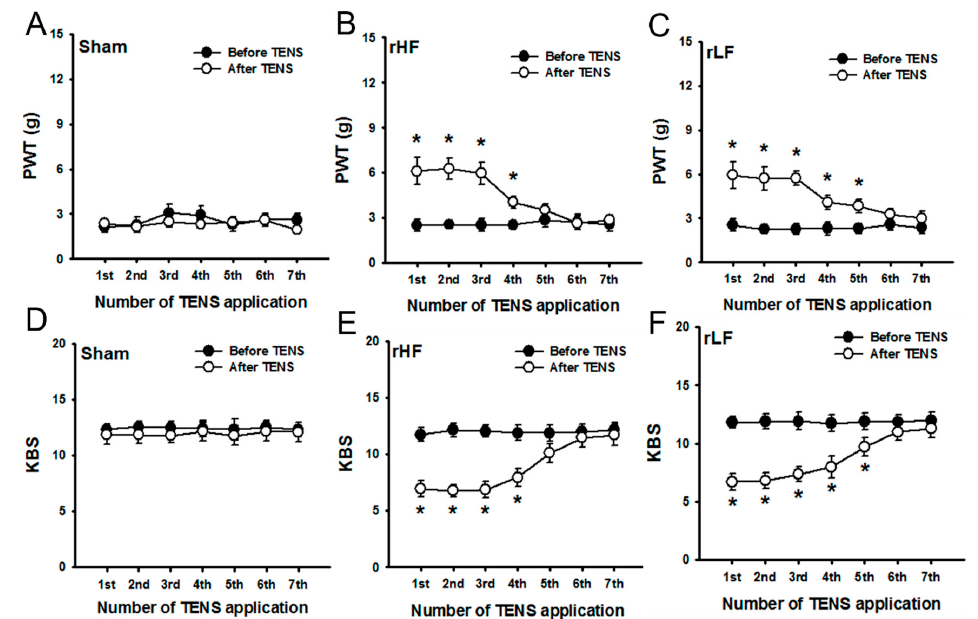
Figure 2. The effects of repeated transcutaneous electric nerve stimulation (TENS) applications on mechanical hypersensitivity in the hind paw and knee joint pain to passive movement in rats with osteoarthritis ( A ) The paw withdrawal threshold (PWT) of the ipsilateral side did not change following repeated TENS applications in the sham TENS group. The PWT in the high-frequency (HF) ( B ) and low-frequency (LF) TENS ( C ) groups significantly changed following the 1st–4th applications